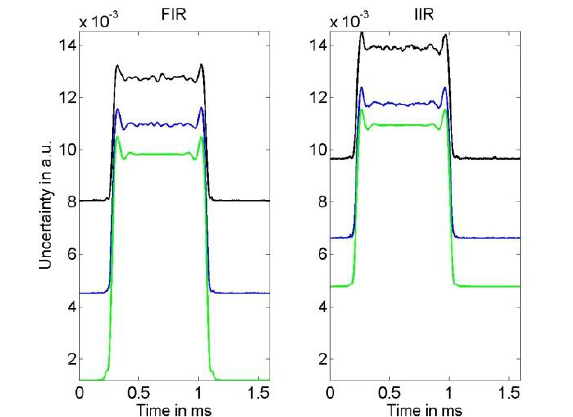
Figure 8. Left: Uncertainty associated with the FIR compensation filter result for three different noise values obtained for the narrow-banded input. Right: Uncertainty associated with the IIR compensation filter result.